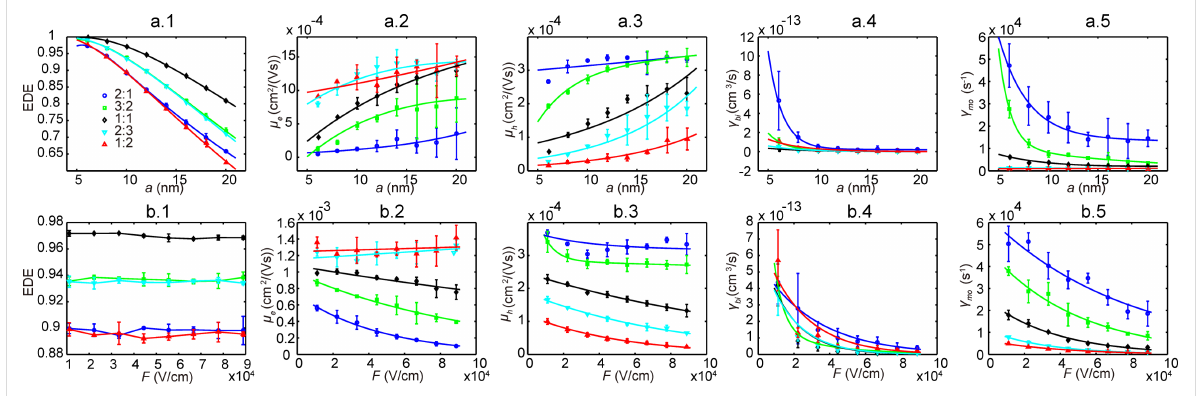
Figure 5: MC simulation results for P3HT/PCBM active layer with different D/A weight ratios. (a.1–5) presents the EDE, electron and hole mobility, bi- molecular and monomolecular recombination rate with respect to domain size. (b.1–5) presents the results with respect to electric field.